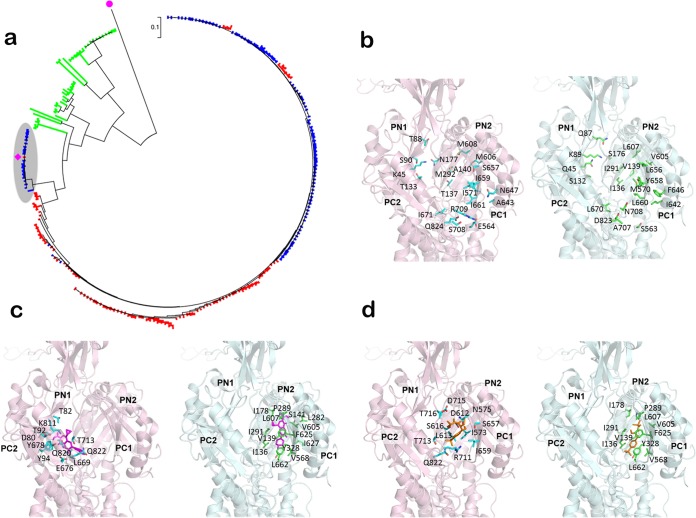
Sequence analysis and structure prediction of CmeB. (a) Phylogenetic analysis of Campylobacter CmeB sequences identified in this study and deposited in the GenBank database. Different Campylobacter species are shown in different colors as follows: red, C. coli; blue, C. jejuni; green, other Campylobacter species. The purple square indicates CmeB of isolate DH161. The unique subtree of RE-CmeB and its homologs from C. jejuni and C. coli is shaded gray. The purple dot indicates multidrug efflux RND transporter AcrB (accession number WP_044694729.1) from E. coli, which was used as the outgroup. (b) The CmeB structures predicted by the Modeller program. For clarity, only the predicted periplasmic domain structures of NCTC 11168 CmeB (pink) and RE-CmeB (DH161, light green) are shown. The 22 mutated residues located in the periplasmic drug-binding cavity of the mutant transporter are represented by green sticks. The corresponding residues in wild-type CmeB are represented by cyan sticks. (c) The predicted bound ciprofloxacin molecules are magenta. The residues involved in binding are represented by sticks. (d) The predicted bound florfenicol molecules are orange. The residues involved in binding are represented by sticks.